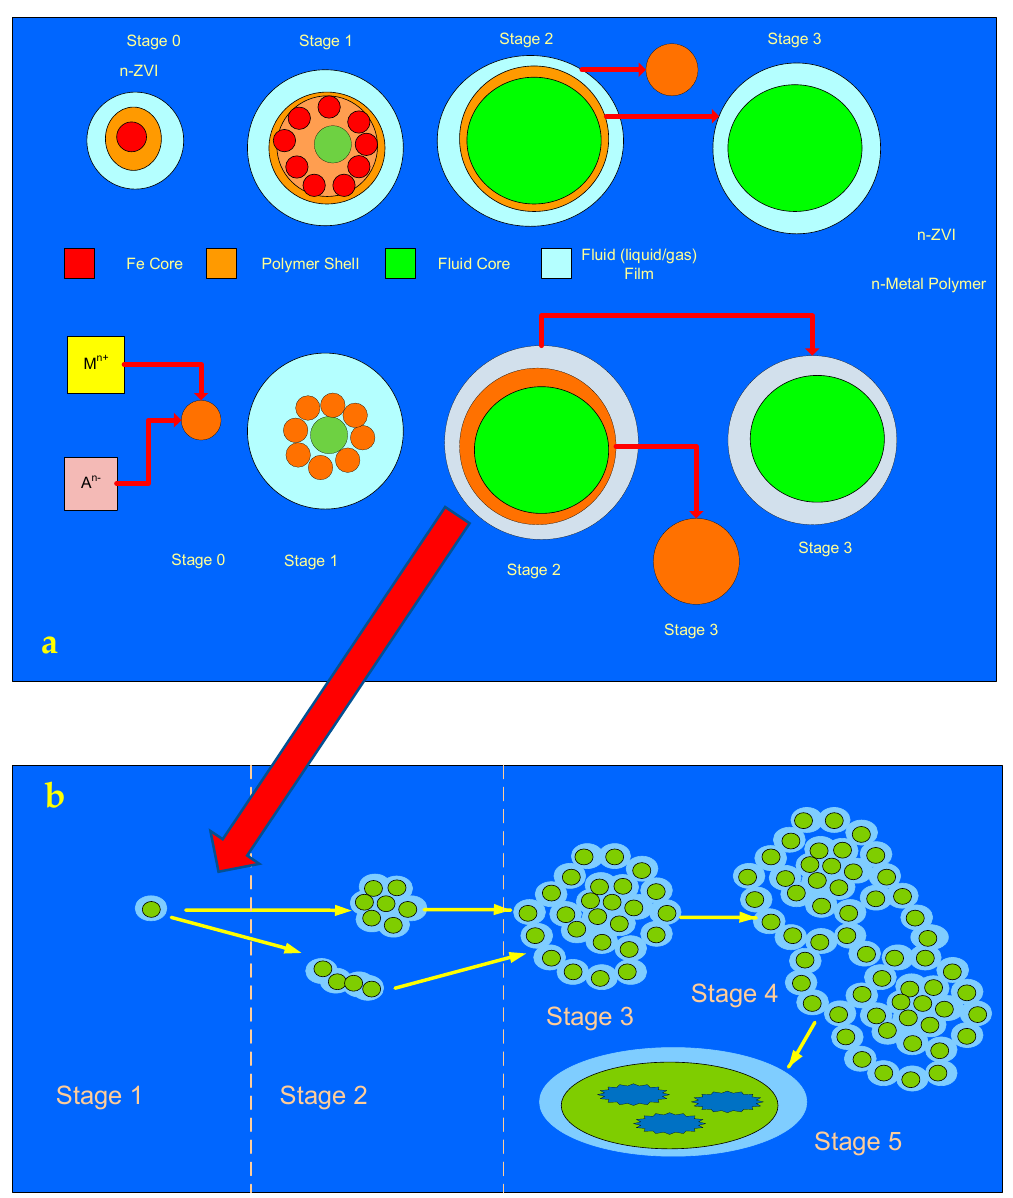
Figure 16. Colloidal aggregate formation. ( a ), Stages in the formation of polymer spheres. M n+ = metal cation; A n − = Anion. ( b ), Stages in the formation of polymer flocculates and colloidal particles. Red arrow provides the link between polymer sphere formation and colloidal aggregate formation.